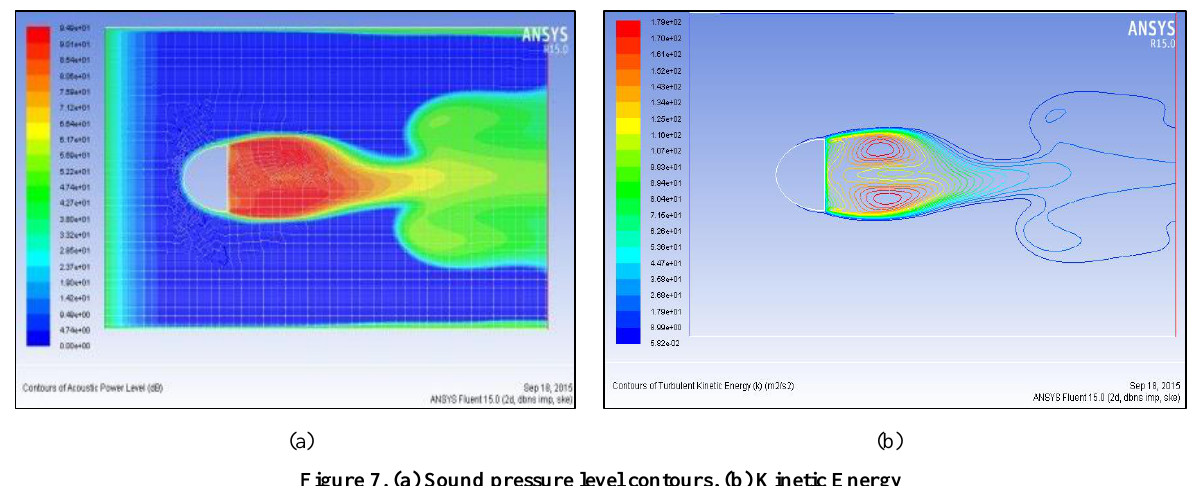
Figure 7. (a) Sound pressure level contours, (b) Kinetic Energy